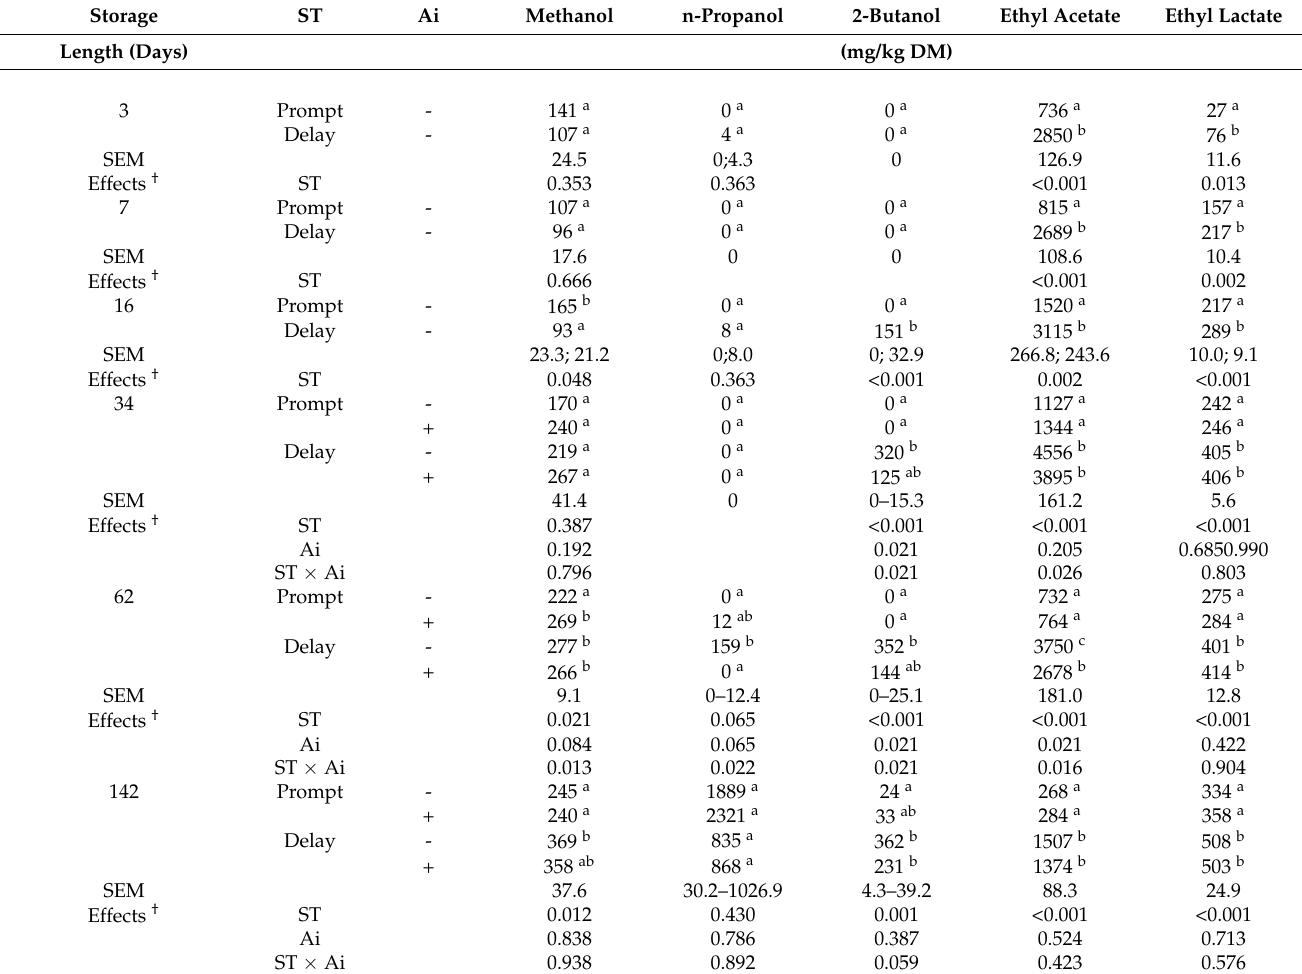
Table 3. Effects of sealing time (ST; 0 h = prompt vs. 24 h = delay) and air ingress (Ai) on volatile organic compounds (VOC) during the course of maize fermentation ( n = 6: d 3, 7, and 16; n = 5: d 16, ST = Prompt; n = 3: d 34, 62, and